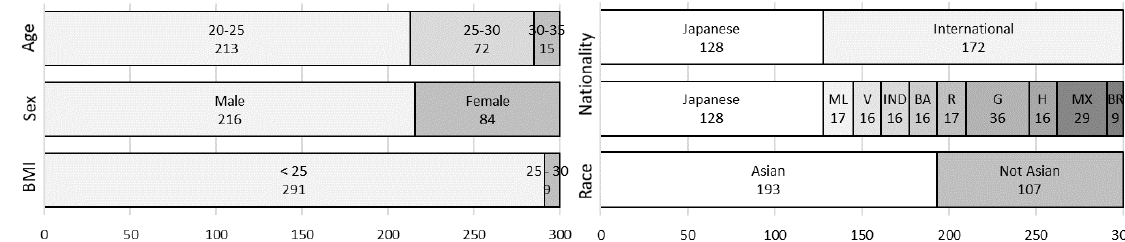
Figure 3. Population sample—Number of votes: Distribution relative to age, sex, nationality, race and BMI. ** ML (Malaysian); V (Vietnamese); IND (Indonesian); BA (Bangladeshi); MX (Mexican);